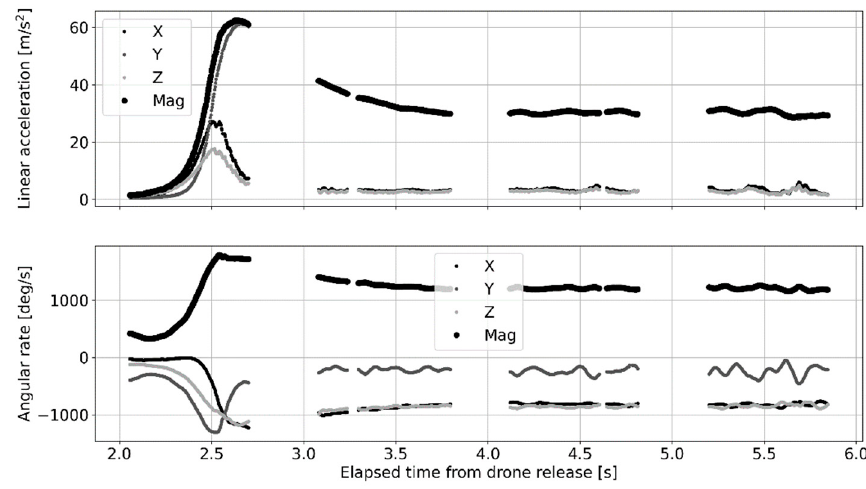
Figure 18. TA2 linear acceleration and rotation rate for 2 < t < 6 s.